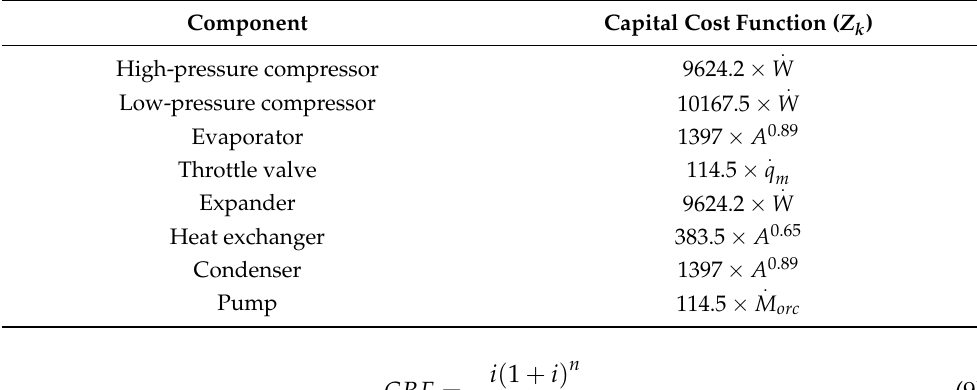
Table 3. Cost functions for estimating the capital costs of the components